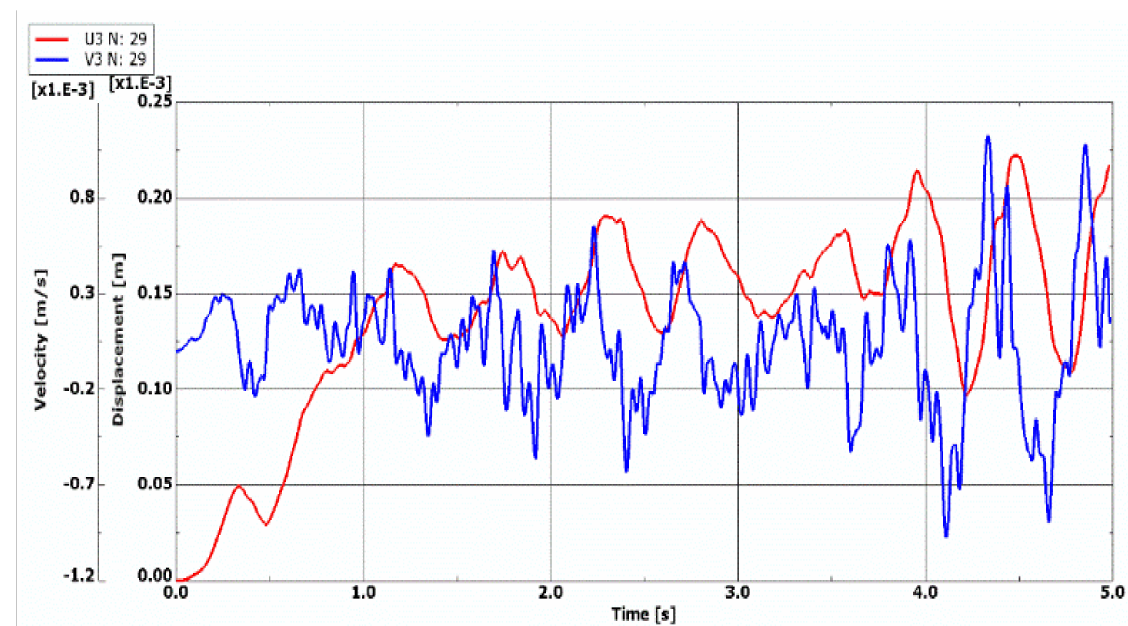
Figure 13. Time histories of deflection and velocity of deflection of the damaged FEM plate model with laminate matrices